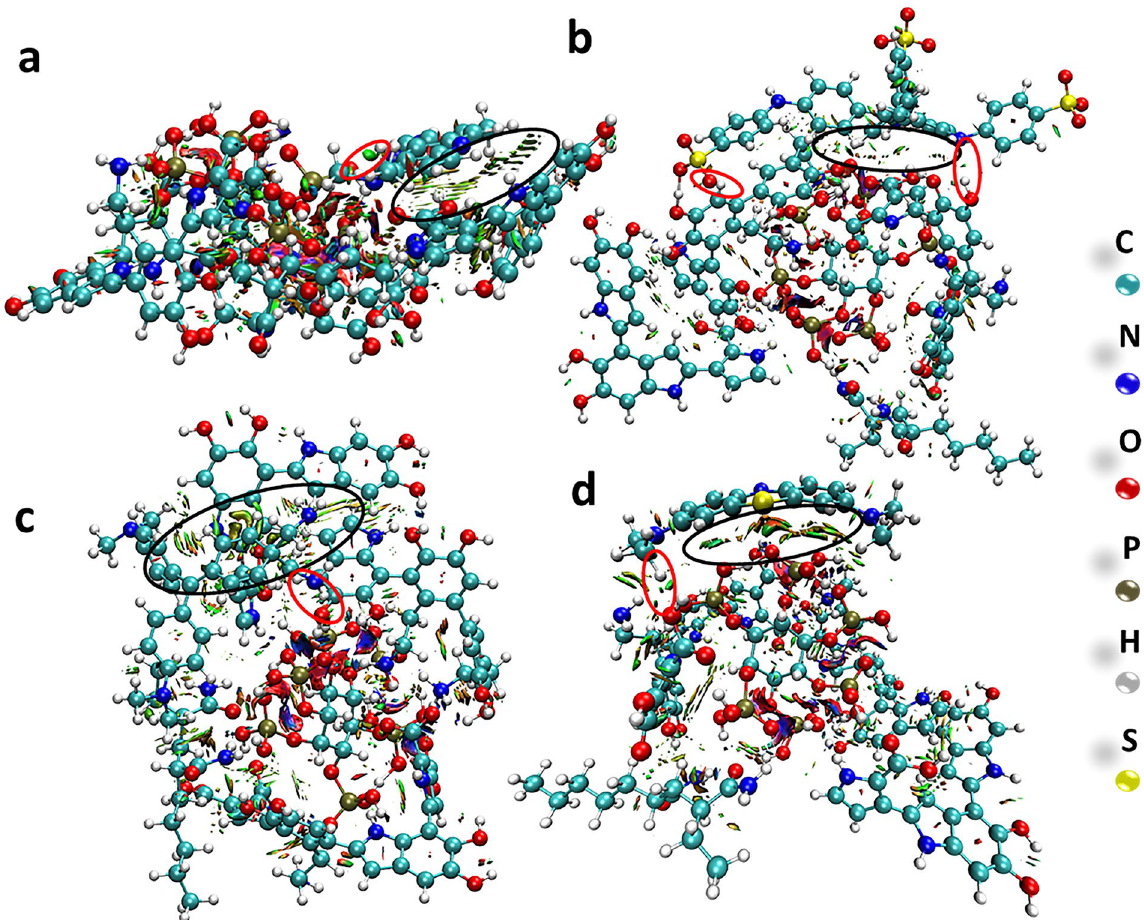
Figure 4. Gradient isosurfaces ( s = 0.5 au) for ( a ) NR-PAAM/PA/PDA hydrogel, ( b ) MB-PAAM/PA/PDA hydrogel, ( c ) MV-PAAM/PA/PDA hydrogel and ( d ) YMB-PAAM/PA/PDA hydrogel through VMD (Visual Molecular Dynamics) 60 , respectively. The surfaces are colored on a blue-green-red scale according to values of sign( λ 2 ) ρ , ranging from − 0.04 to 0.02 au. Blue indicates strong attractive interactions, and red indicates strong nonbound overlap. Large and negative values of sign( λ 2 ) ρ indicate attractive interactions (such as dipole-dipole or hydrogen bonding, blue color), while large and positive values of sign( λ 2 ) ρ represent nonbonding (red color). The values of sign( λ 2 ) ρ near zero indicate van der Waals interactions, such as π - π stacking